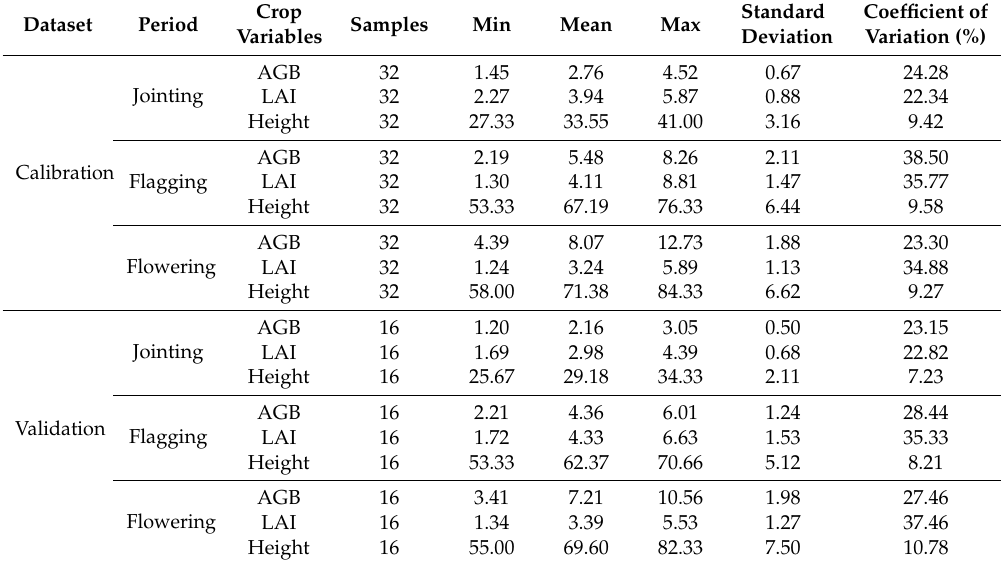
Table 3. Descriptive statistics of above-ground biomass (AGB, t/ha), and leaf area index (LAI, m 2 /m 2 ), and crop height (cm) from the study